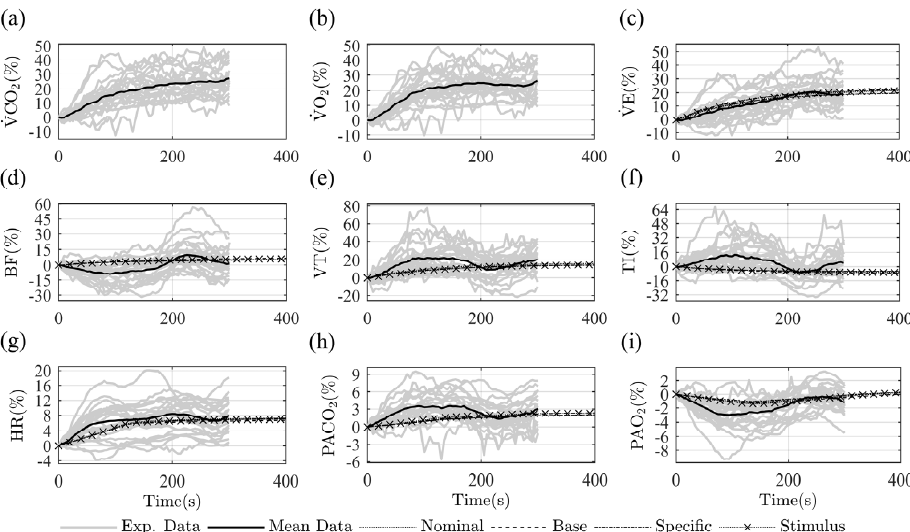
Figure 6. Transient results for a single load step. Model inputs correspond to variations of VO 2 and VCO 2 from 0.64 to 0.82 L/min and 0.58 to 0.76 L/min, respectively. They were obtained from the experimental mean values at the beginning and end of the first exercise load step. The dotted lines are the simulation results under nominal conditions (Nominal); the dashed lines are the simulation results at the first fitting stage (Base); the dash-dot lines are the simulation results at the second fitting stage (Specific); and the dotted lines with cross marker are the simulation results at the third fitting stage (Stimulus). The simulation results are compared with the corresponding experimental data. The solid gray and black lines represent the subject-by-subject experimental data restricted at AT , and their total mean value. The subfigures from ( a ) to ( i ) correspond to the result for each of the variables evaluated.